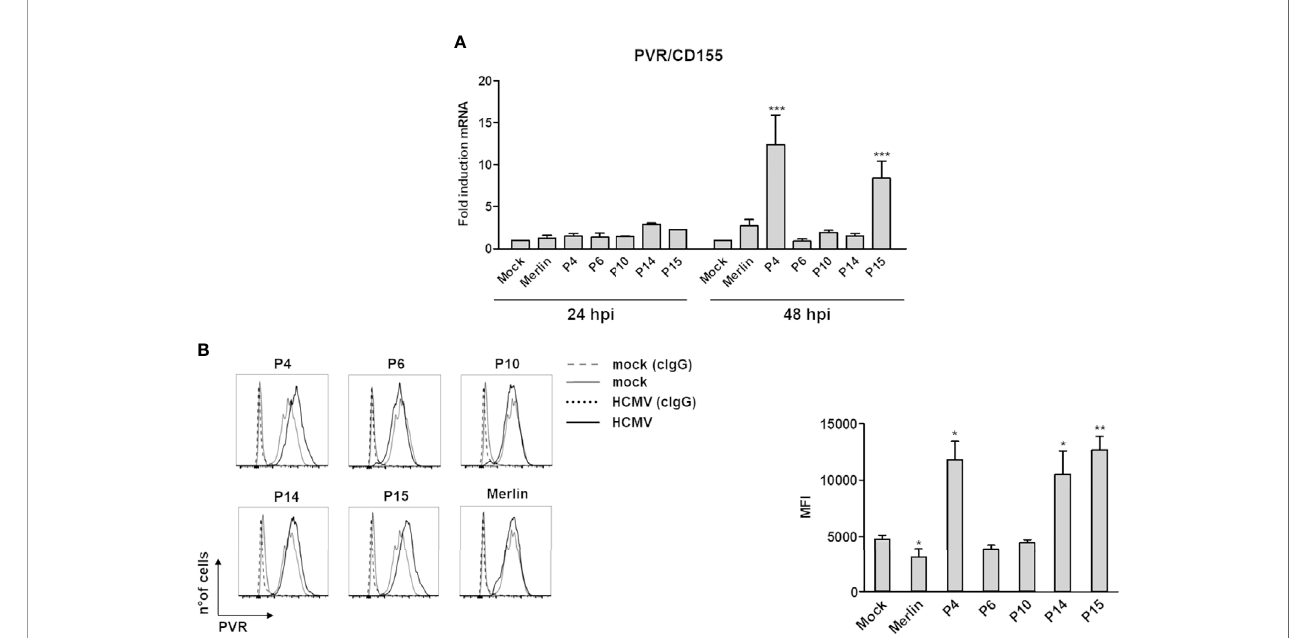
FIGURE 1 | Modulation of the NK cell ligand PVR/CD155 by HCMV clinical isolates. (A) Primary human foreskin fi broblasts (HFFs) infected with the indicated clinical isolates (P4, 6, 10, 14, and 15), the Merlin strain, or uninfected (mock) were co-cultured with an excess of uninfected HFFs, as described in Materials and Methods, and subjected to RT-qPCR to measure PVR/CD155mRNA expression levels. Values were normalized to the housekeeping gene glyceraldehyde-3-phosphate dehydrogenase (GAPDH) mRNA and plotted as fold induction relative to mock-infected cells (set at 1). Data from three experiments performed at 24 and 48 hours post-infection (hpi) are shown. Error bars show standard deviation (SD) (*** P < 0.001; two-way ANOVA followed by Bonferroni ’ s post-tests, for comparison of infected vs. mock cells). (B) FACS analysis assessing PVR/CD155 expression at 3 days post-infection. Left panel: a representative experiment of at least four performed with all HCMV isolates is shown. Dashed and dotted lines indicate isotype control in mock or HCMV-infected cells, respectively. Right panel: data derived from at least four experiments performed with all HCMV isolates. PVR/CD155 expression levels are presented as mean fl uorescence intensity (MFI) ± SE (* P < 0.05; ** P < 0.01, paired Student t test for comparison of infected vs. mock